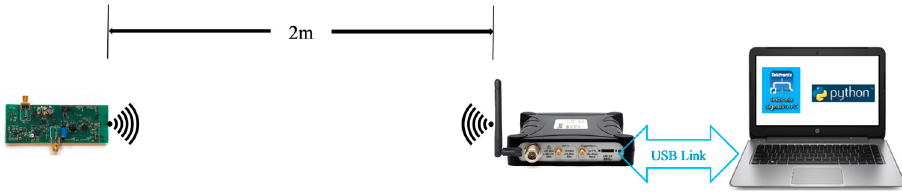
Figure 4. Experiment schematic.